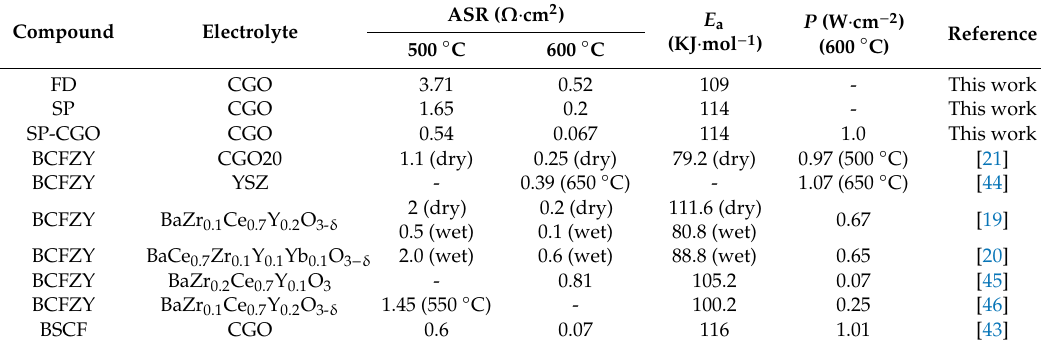
Table 1. Area specific resistance, activation energy and power density values reported in the literature